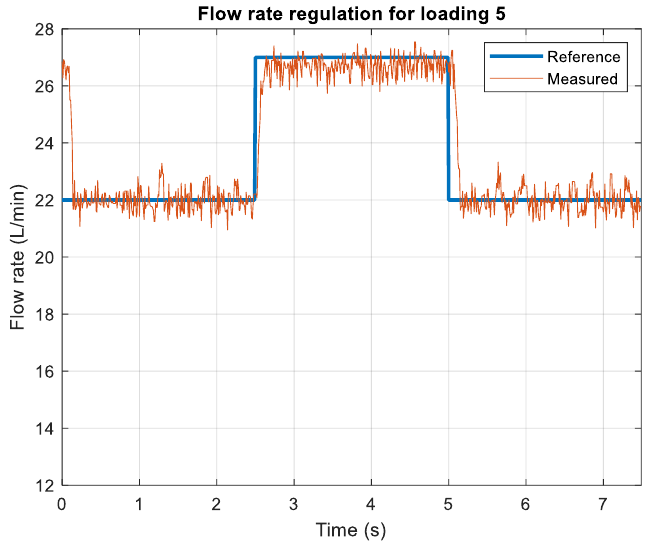
Figure 17. Experimental results for loading condition 4.